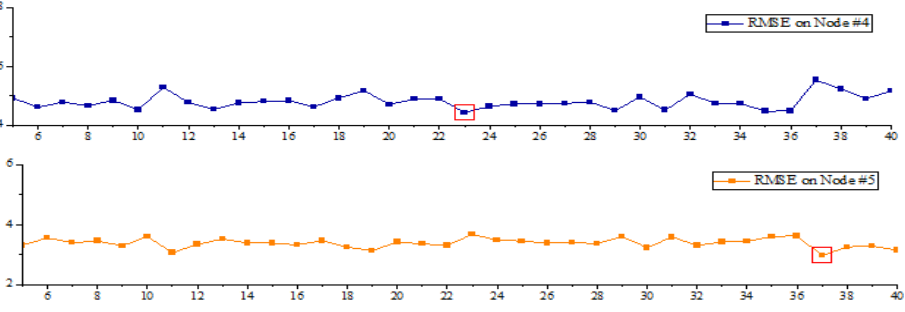
Figure 7. Validation errors of local models at node #3. All the red boxes in the figure represent the current nodes optimal RMSE values that we have marked. current nodes optimal RMSE values that we have marked.